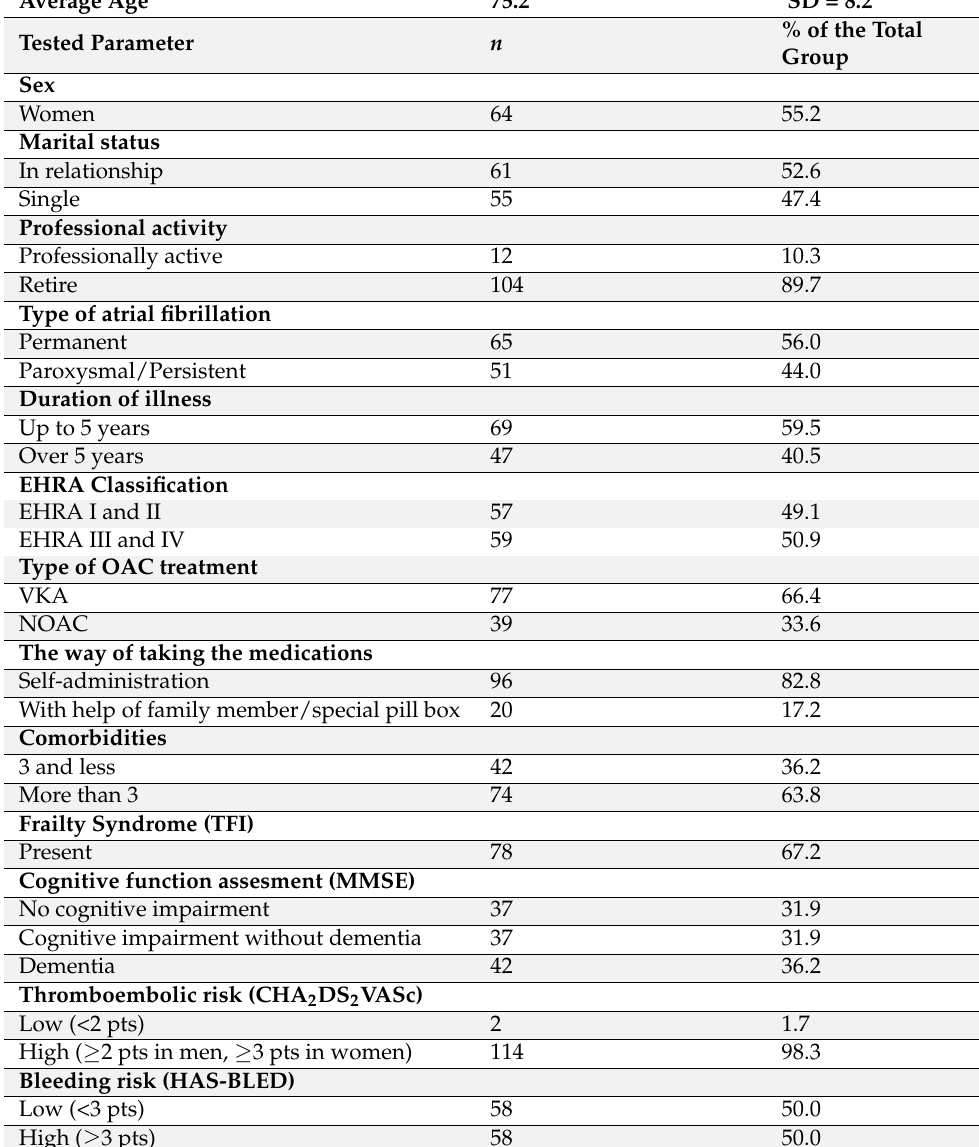
Table 1. Sociodemographic and clinical characteristics of the study group ( n = 116).